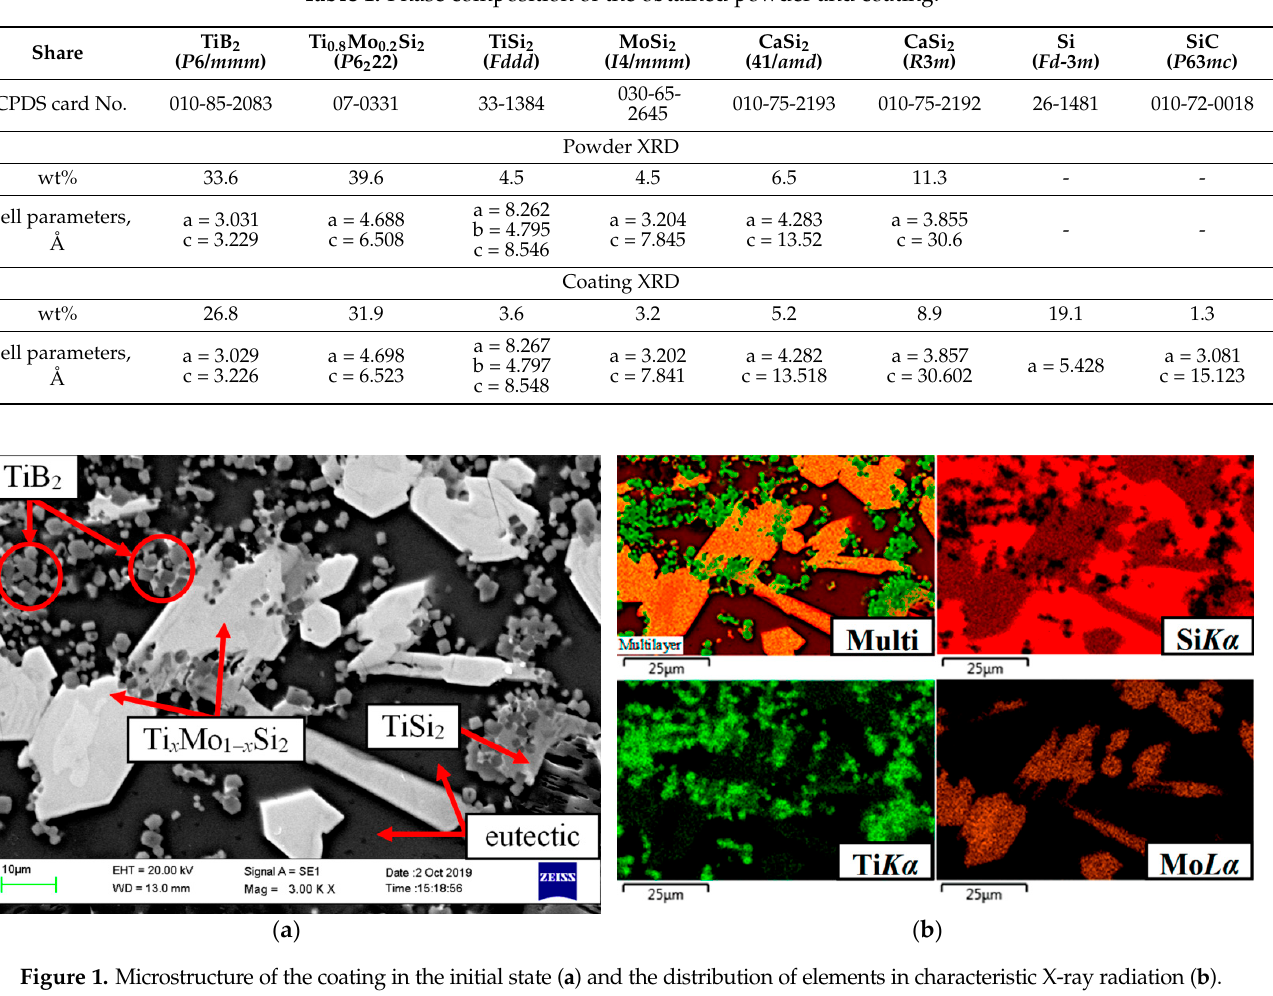
Table 1. Phase composition of the obtained powder and coating.